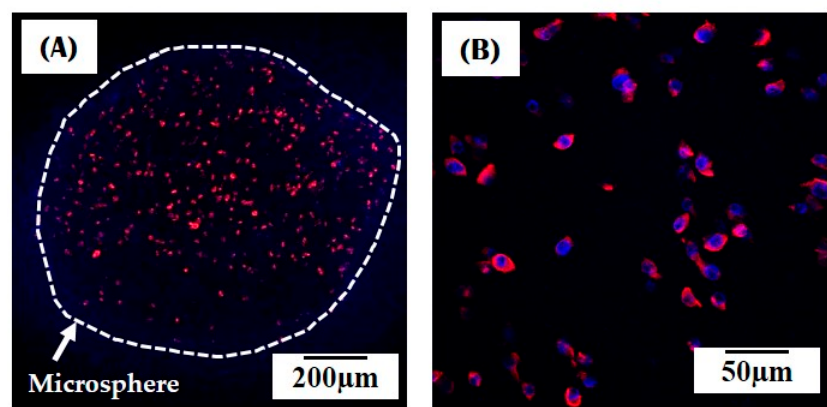
Figure 11. Representative confocal laser scanning microscopy (CLSM) images of the cell-loaded collagen microsphere: ( A ) Low magnification; ( B ) High magnifications.